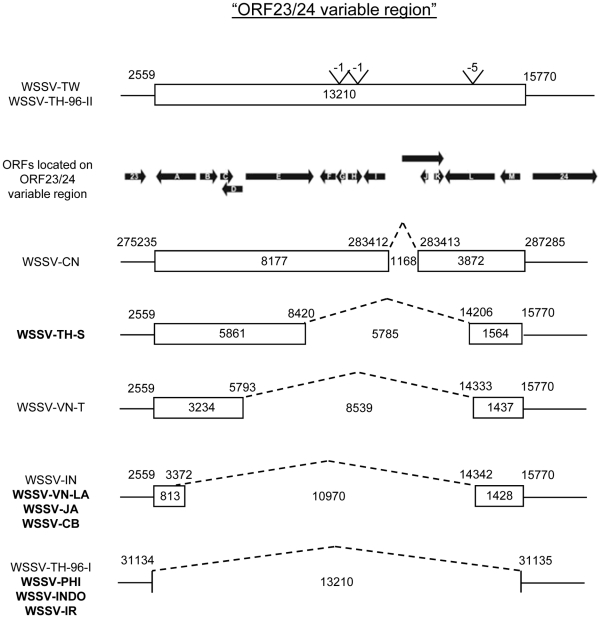
Schematic representation of the ORF23/24 variable region of the Asian WSSV isolates.The coordinates of the WSSV-Asian isolates are according to the WSSV-CN or WSSV-TH annotation. Names of WSSV isolates characterized in this study are in bold. The length of the fragments is indicated within boxes or sequences. The positions of the ORFs located in this region are indicated by closed arrows, which also represent the direction of transcription. ORFs are numbered in accordance to previous studies [8], [10].